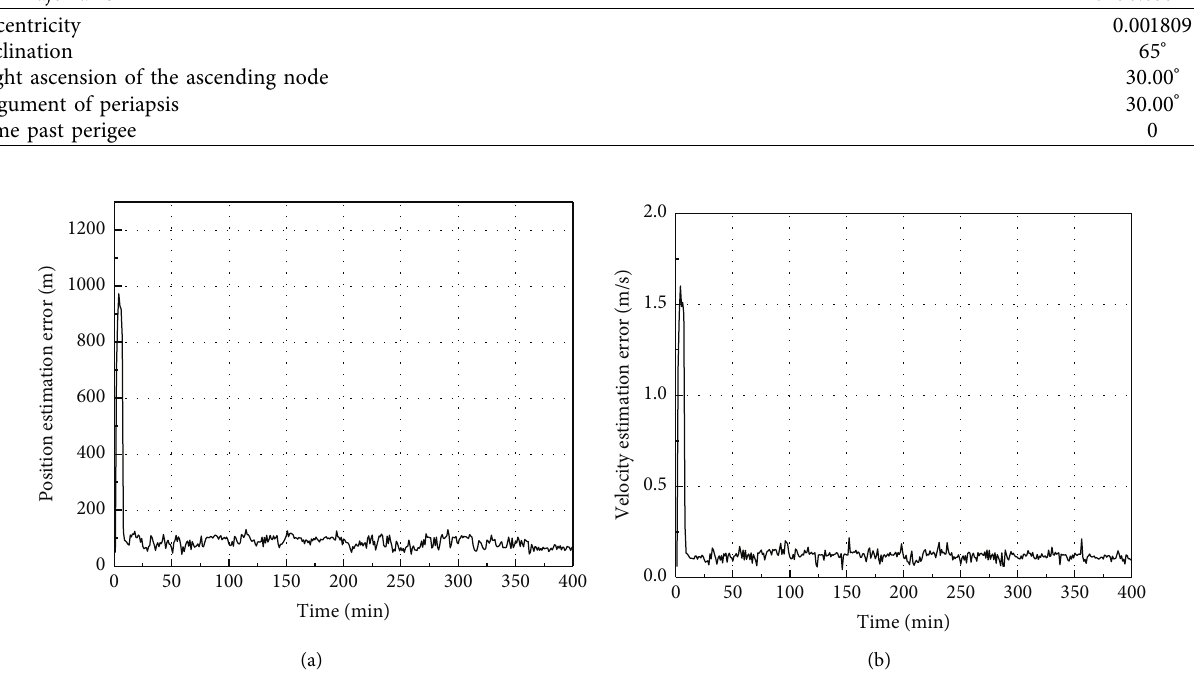
Figure 5: UKF simulation results. (a) Position estimation error; (b) velocity estimation